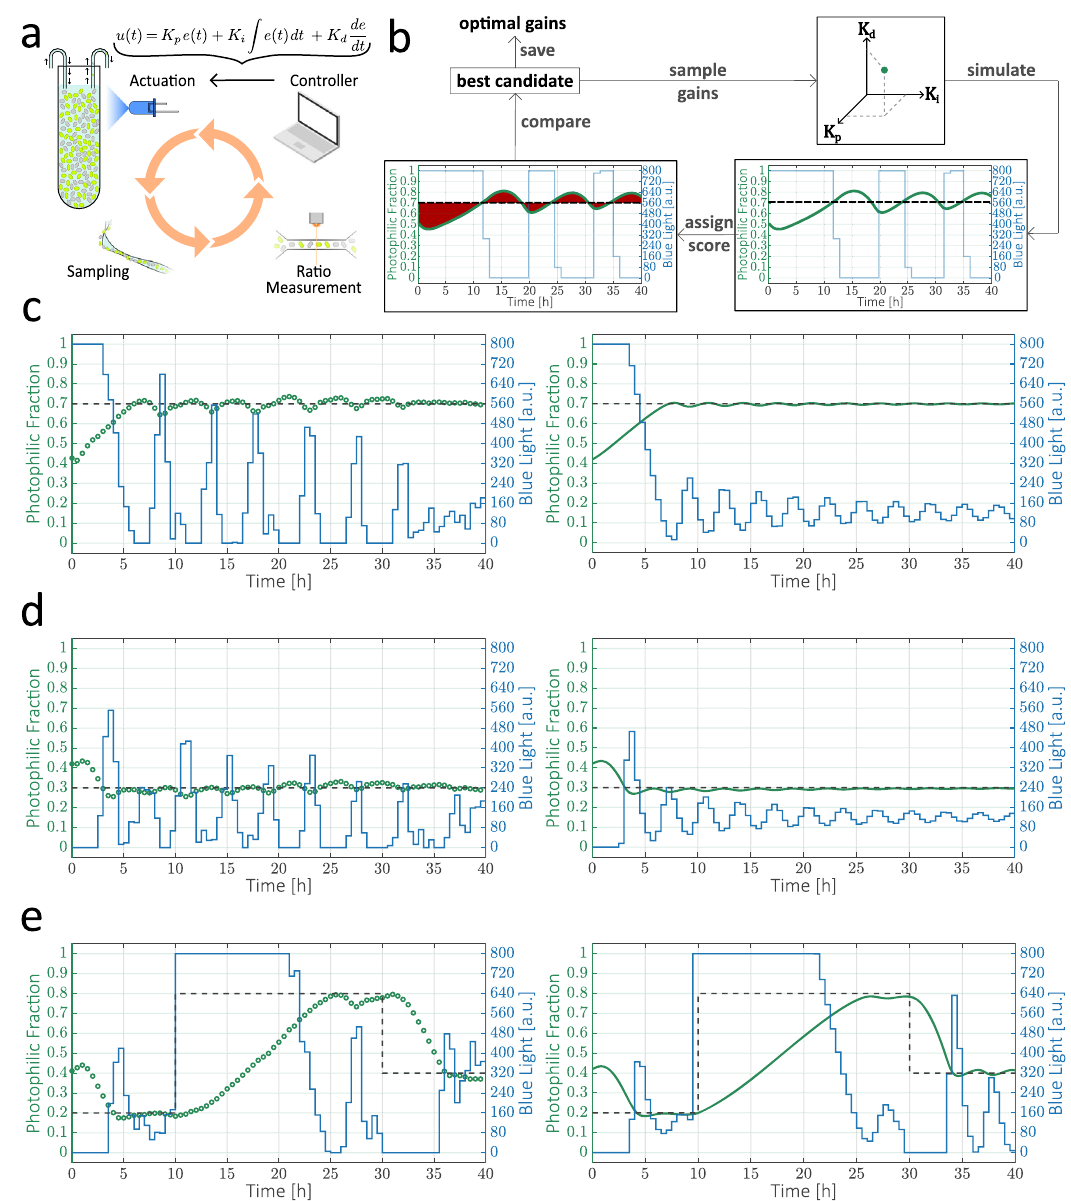
Fig.6|Computationalscreeningforoptimalcontrollerparametersandclosed- loop control of co-culture composition. a Schematic of closed-loop control experimentwithaPIDcontroller. b ComputationalscreeningforoptimalPIDgains. Sets of randomly sampled gains ( K p , K i , K d ) are used to simulate the expected trajectory of the co-culture in a closed-loop setting with a de fi ned target setpoint. Trajectories are scored according to their total deviation from the target strain